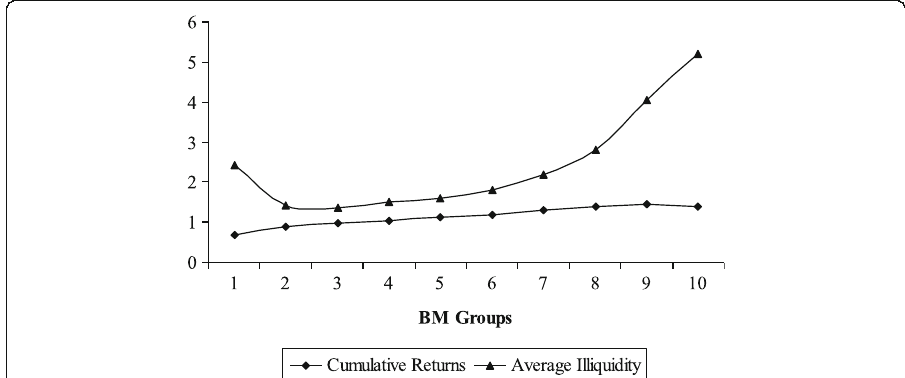
Fig. 1 Plot of cumulative returns and average normalized illiquidity for 10 book to market groups. Portfolios are formed using book-to-market data at the end of April for each year in the 33-year period between 1968 through 2000 for all AMEX and NYSE stocks identified on CRSP